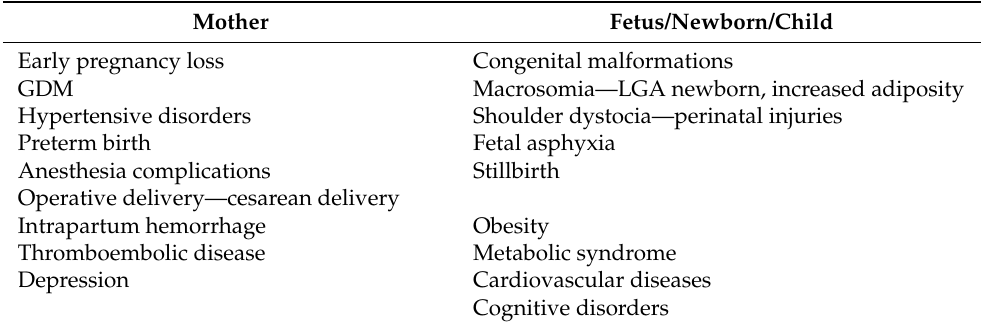
Table 1. Pregnancy risks and consequences for the baby in overweight and obese